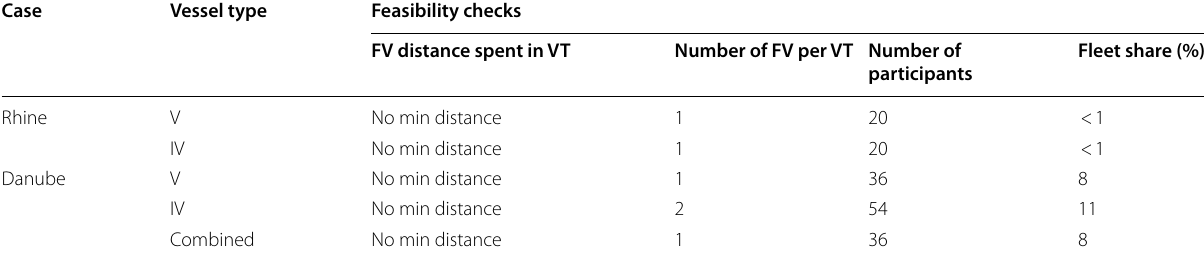
Table 9 Feasibility checks for the Rhine and the Danube cases Case Vessel